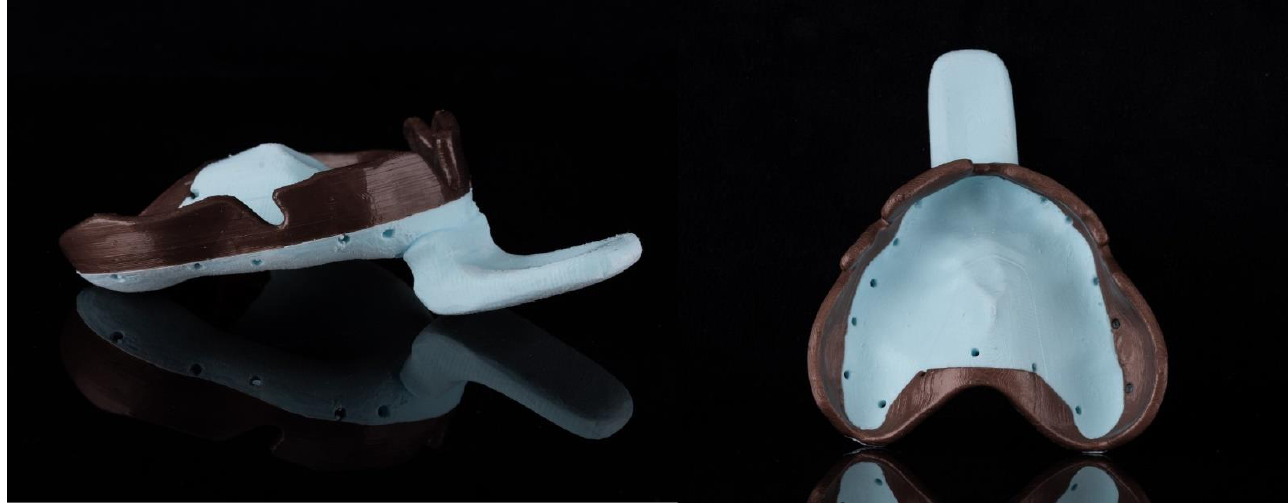
Figure 5. Dual material customized impression tray. The rigid body was manufactured with a polyethylene terephthalate glycol (PETG) filament (Trayfill), the rim was printed with a thermoplastic filament.